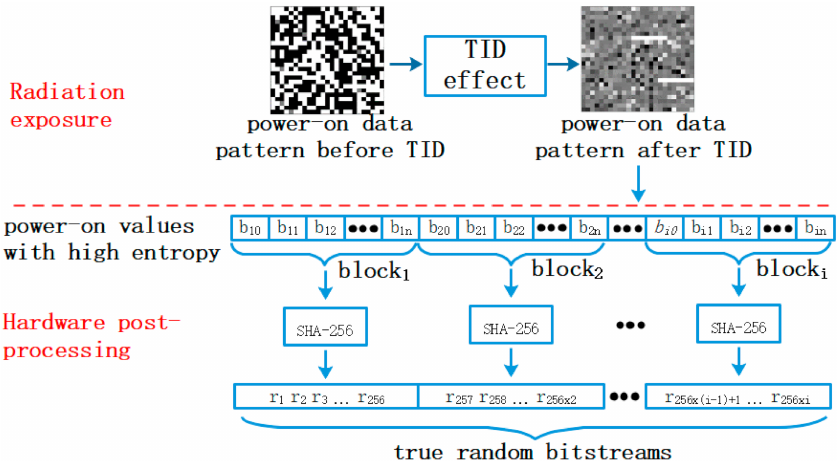
Figure 2. Flow of the proposed true random number generator (TRNG) scheme, including two stages: radiation exposure and hardware